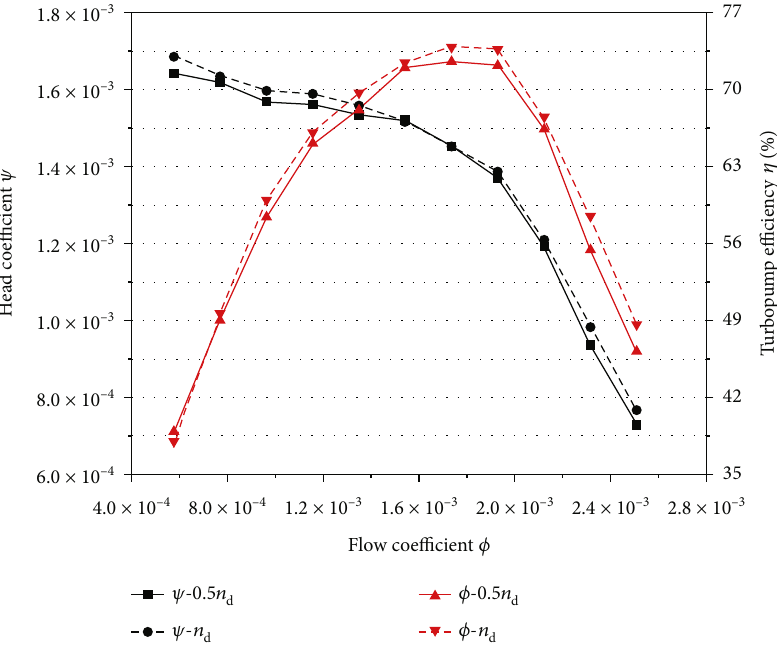
Figure 7: Comparison of the performance under di ff erent rotational speeds.